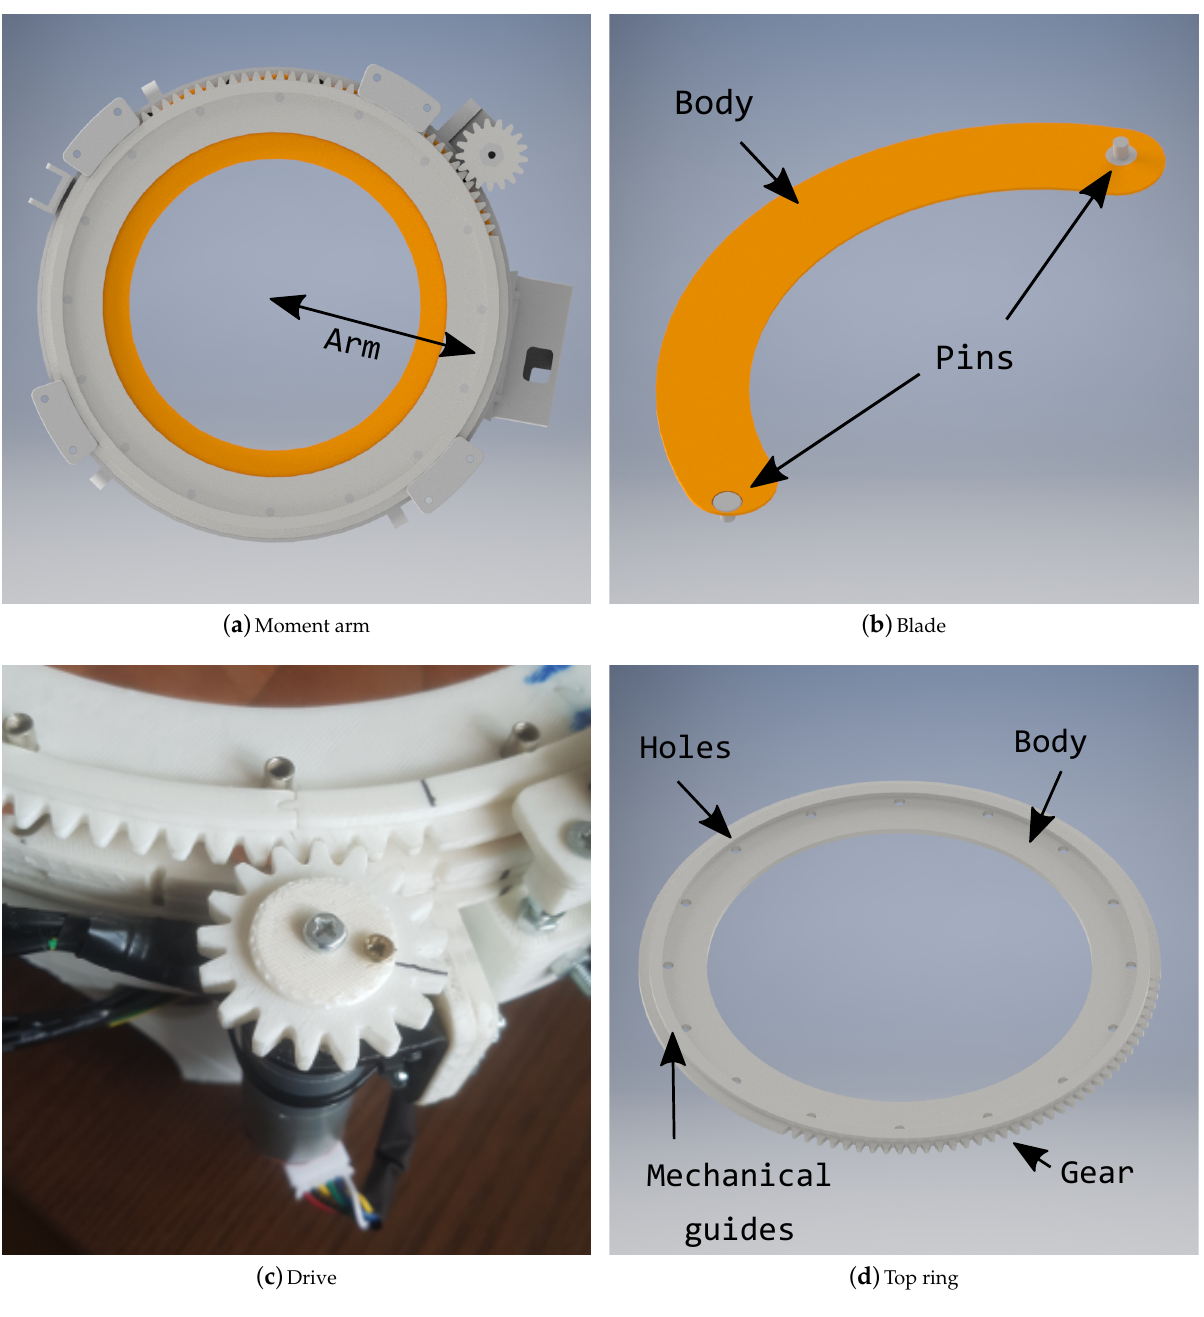
Figure 6. Several parts of the smart